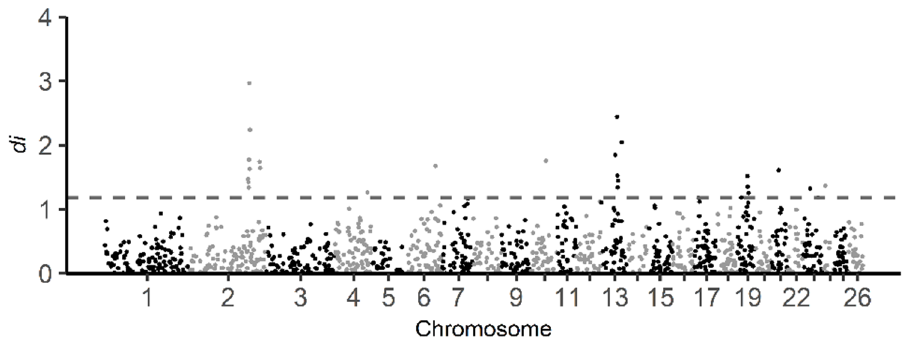
Figure 5. Box plots of within-breed distribution of runs of homozygosity inbreeding coefficient for each sheep breed.